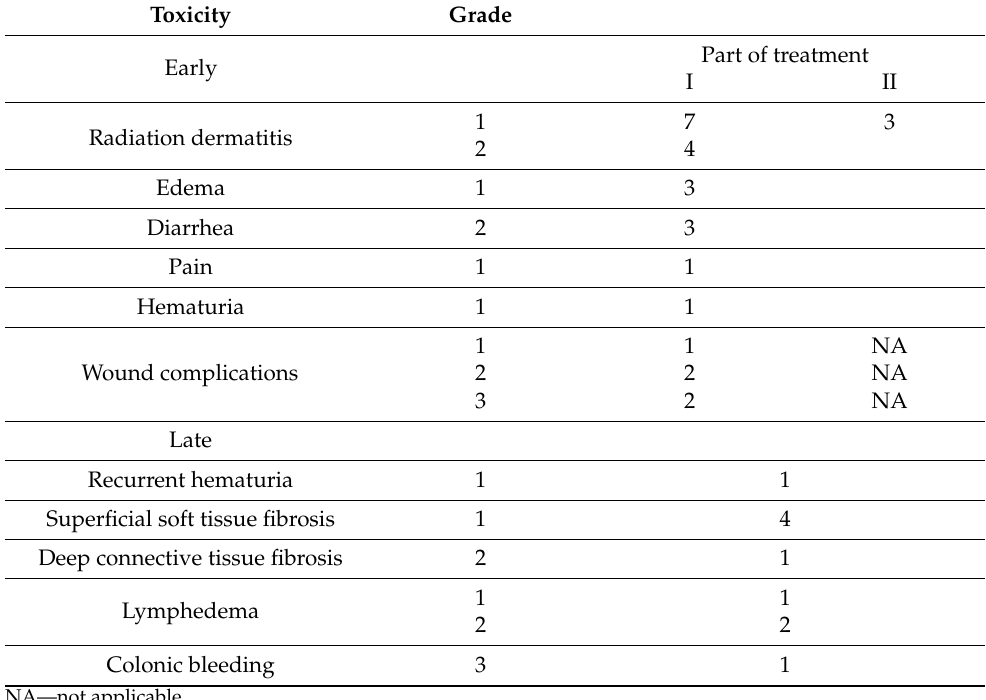
Table 3. Toxicity of radiotherapy.